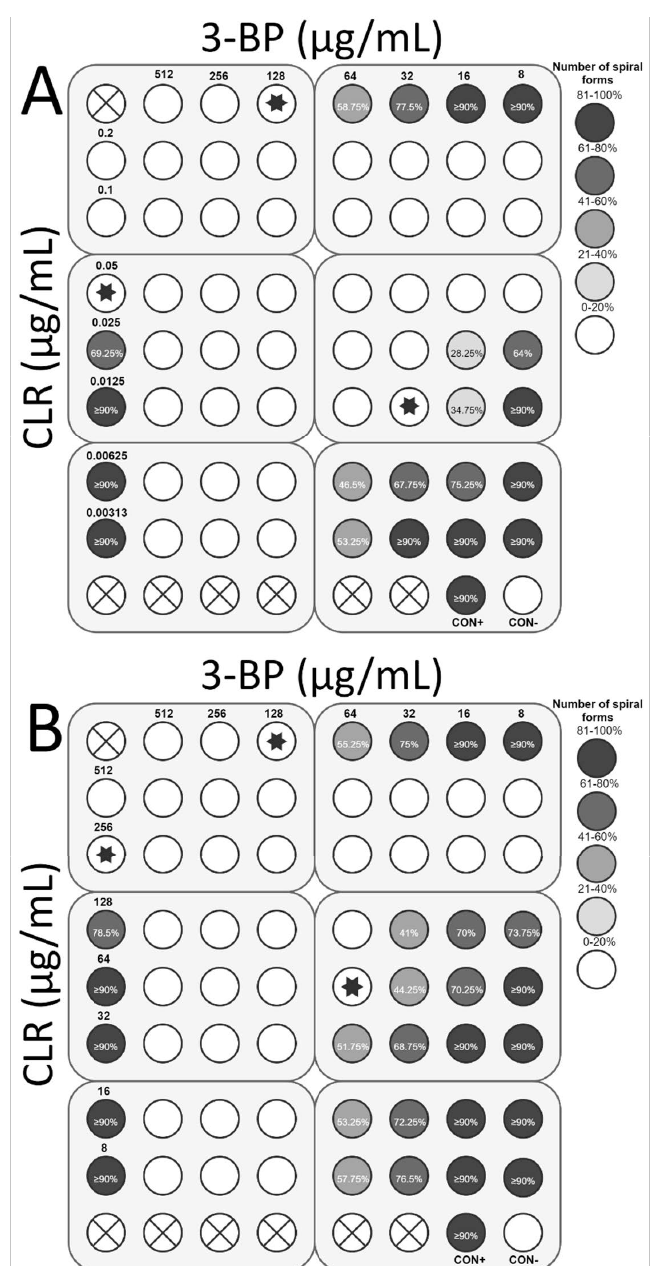
Figure 8. The antibacterial and morphological effects of 3-Bromopyruvate (3-BP), clarithromycin (CLR), and combinations of both against H. pylori Tx30a and 7143 strains: The existence of the interaction in the antimicrobial activity of 3-BP with CLR was determined against ( A ) the reference antibiotic-susceptible H. pylori Tx30a and ( B ) the clinical double-resistant H. pylori 7143 strain. The white circles indicate the wells in which the number of spiral forms was ≤ 15%, while the white circles with a cross in the middle indicate empty wells. Using asterisks, the wells with the MICs of the tested substances were marked, whereas in the case of the interaction verifications, they indicate the lowest FIC. Abbreviations: 3-BP, 3-Bromopyruvate; CLR, Clarithromycin; CON+, Positive control; and CON − , Negative control.